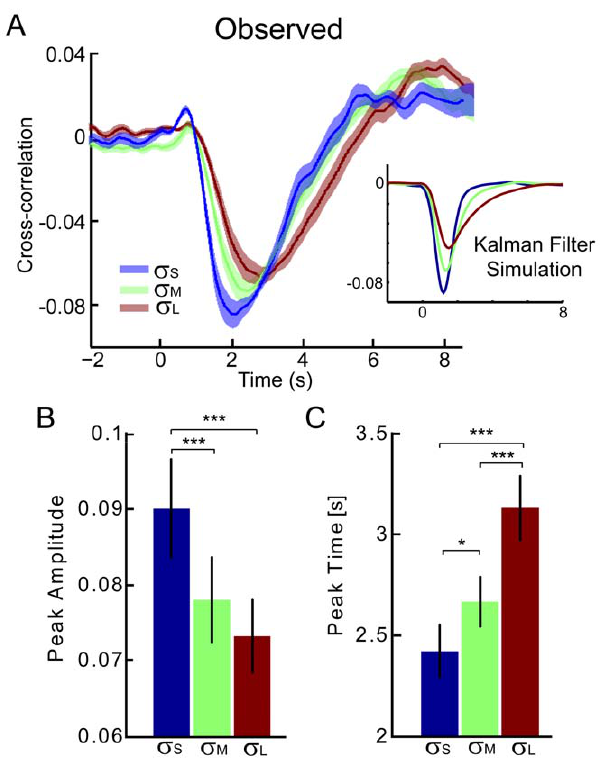
Figure 3. Cross-correlations between process noise and COP. A) Cross-correlation between the fluctuations in cursor acceleration (process noise, g ) and the center of pressure with time lag for each feedback uncertainty level. The inset shows the cross-correlation between fluctuations in the cursor acceleration and the Kalman update in a simulation. The results have been smoothed to mimic postural responses (Gaussian smoothing, s =250 ms) B) Peak amplitude for each feedback uncertainty level. C) Peak time for each feedback uncertainty level. Confidence intervals denote SEM (N=10). * denotes p , 0.05; *** denotes p , 0.001 (one-sided paired